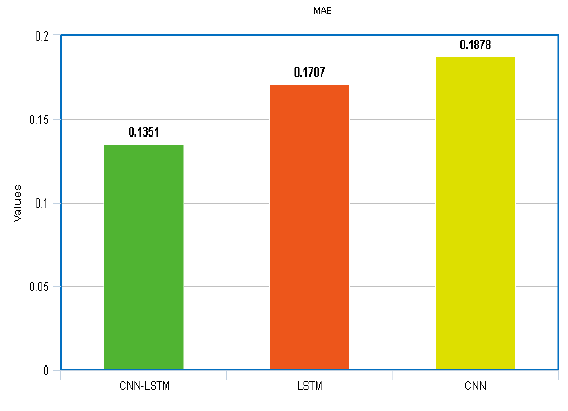
Figure 12. MAE comparison on TATAMOTORS